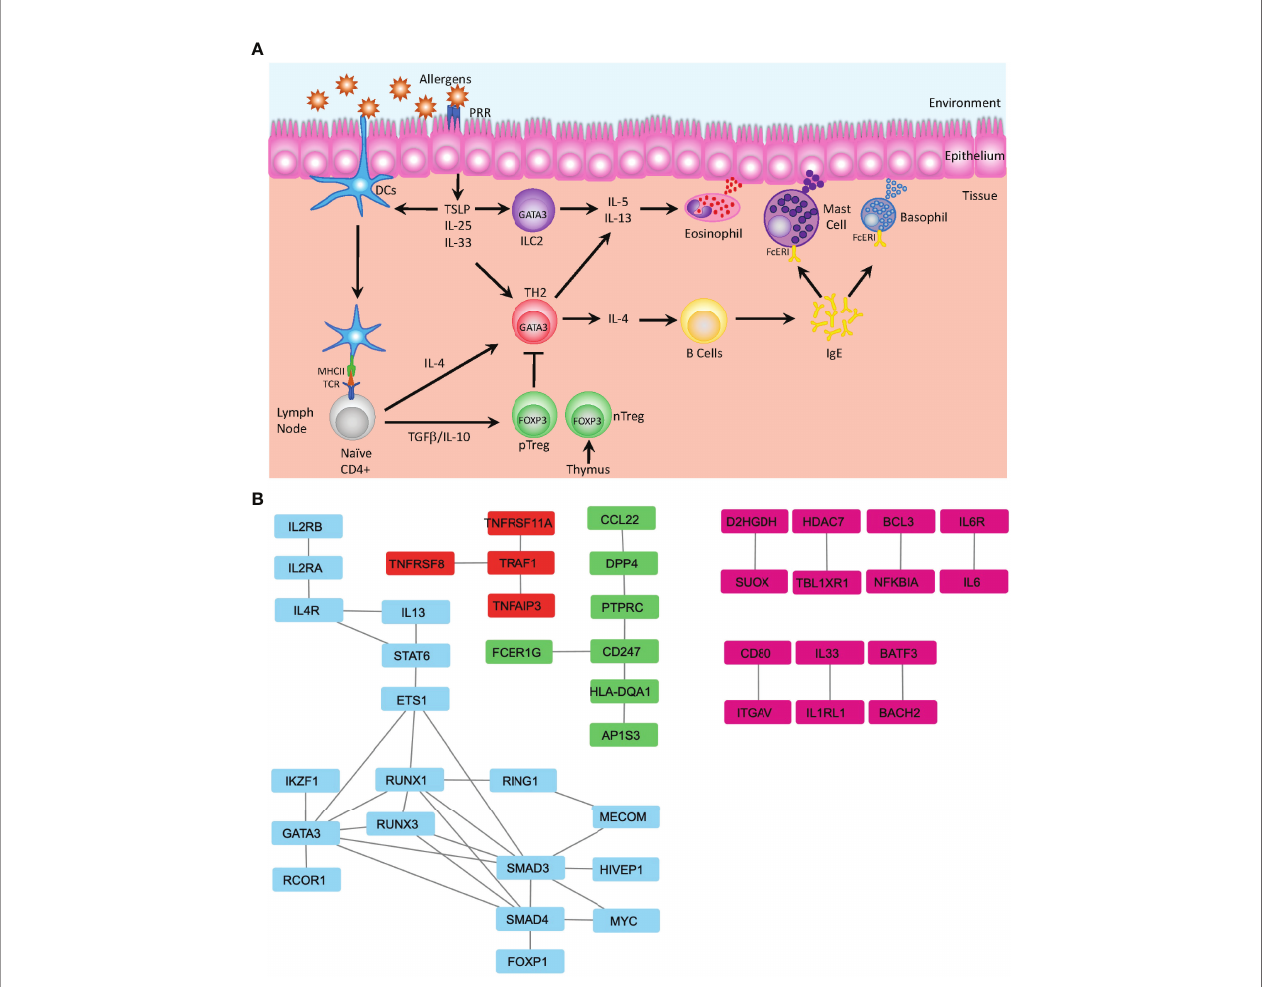
FIGURE 2 | Mechanisms of Allergic Disease Development. (A) Representative image depicting the fi rst stage of an allergic response driven by the recognition of environmental allergens as in fl ammatory mediators by pattern recognition receptors (PRR) present on the surface of dendritic cells (DC) and epithelial cells in barrier tissues. Epithelial cells produce defensive cytokines including TSLP, IL-25 and IL-33 that modulate activated DC and direct naïve T cells towards the TH2 phenotype. In the absence of in fl ammatory stimuli, naïve T cells may be activated in a tolerogenic manner and differentiate to become peripherally induced Treg cells (pTreg), which in concert with thymically produced T regs (nTreg), mediate the dampening of in fl ammatory responses. Activated TH2 cells produce IL-4 and mediate B cell class switching and production of IgE. Together with ILC2, Th2 cells additionally produce IL-5 and IL-13 that regulate the activation of the innate immune system and induces migration of eosinophils, mast cells and basophils to the sites of in fl ammation, where IgE bound to the FcERI receptors on mast cells and basophils recognizes the cognate allergen. This induces degranulation and release of further in fl ammatory mediators including histamine, leukotrienes, and heparin. (B) Analysis of protein-protein interactions of the 216 genes identi fi ed by GWAS from Han et al. (19) using the STRING database (48). Identi fi cation of several clusters of highly relevant pathways that overlay with the known functional pathways previously associated with asthma and allergic diseases, including the major cytokines signals associated with TH2 differentiation (IL-2, IL-4 and IL-13) along with the downstream mediators of differentiation — STAT6 and GATA3 — and transcription factors associated with Treg differentiation — FOXP1 and SMAD — which are involved in the TGF b signaling (blue). Additionally, the TRAF1 signaling nexus is identi fi ed, where TRAF1 has previously been identi fi ed as a key factor in allergic in fl ammation and the regulation of IL-4 production (red) (49). FcERI signaling and interactions between TCR and MHCII (HLA-DQA1) are identi fi ed (green) and multiple pairs of protein-protein interactions integral for development of allergic in fl ammation are also identi fi ed (pink) — notably IL-33-IL1RL1 (50) and BATF3-BACH2 (51). Data displayed is developed using Cytoscape v.3.9 (eQTL), admixture mapping, and polygenic risk scores (PRS), in identi fi ed, may help to better understand the etiology of the disease. eQTL analysis is an effective tool used to identify the